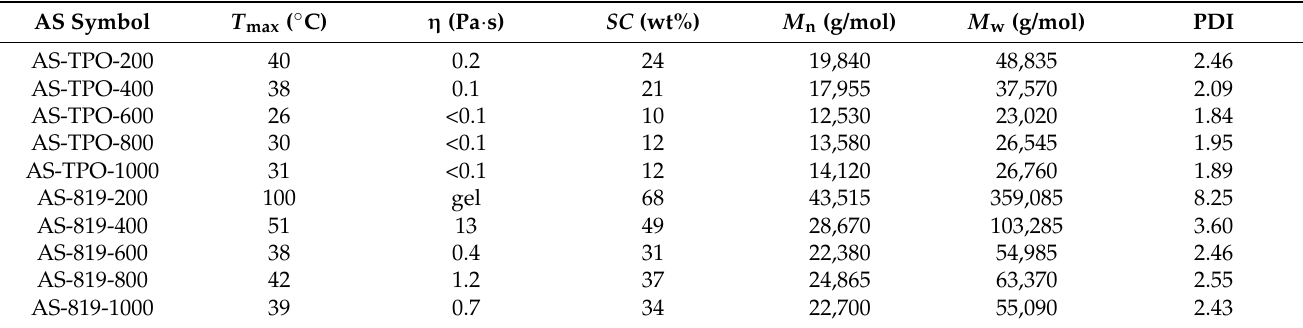
Table 2. Dynamic viscosity, solids content, average molecular weights, and polydispersity of the acrylic syrups. AS